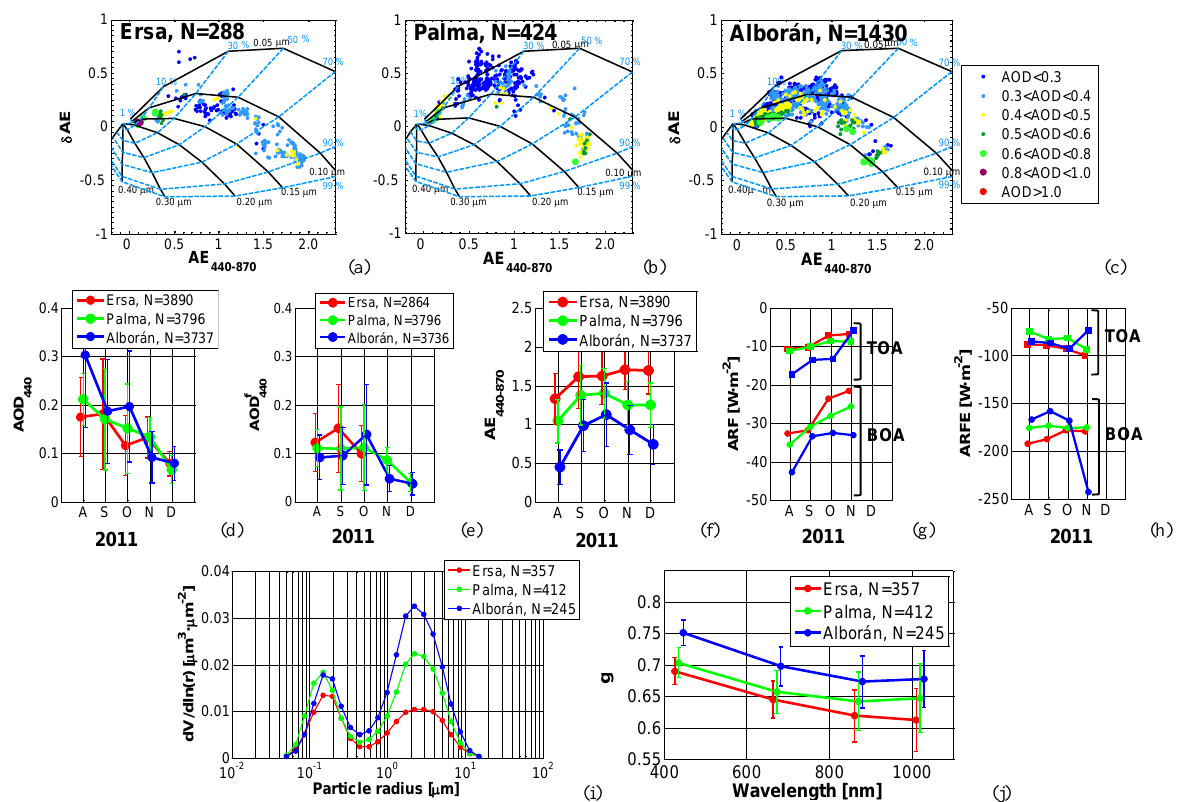
Figure 13. ( δ AE, AE) plot at (a) Ersa, (b) Palma and (c) Alborán over the whole period from August to December 2011; monthly variations of (d) aerosol optical depth at 440nm (AOD 440 ) , (e) the fine-mode aerosol optical depth at 440nm (AOD f AE 440 − 870 , (g) the aerosol radiative forcing (ARF) and (h) the aerosol radiative forcing efficiency (ARFE); (i) the columnar size distribution and (j) spectra of the asymmetry factor ( g) averaged over the whole period. The data are from AERONET level 2.0 inversion products during the period August to December 2011. BOA and TOA stand for bottom and top of the atmosphere, respectively. The numbers of points in the plots (g) and (h) (not indicated in the plots for the sake of clarity) are 123, 133 and 101 for Ersa, Palma and Alborán, respectively. The color code is the same in all figures (d) – (j) : red, green and blue for Ersa, Palma and Alborán, respectively. In (g) – (h) the error bars are omitted for the sake of